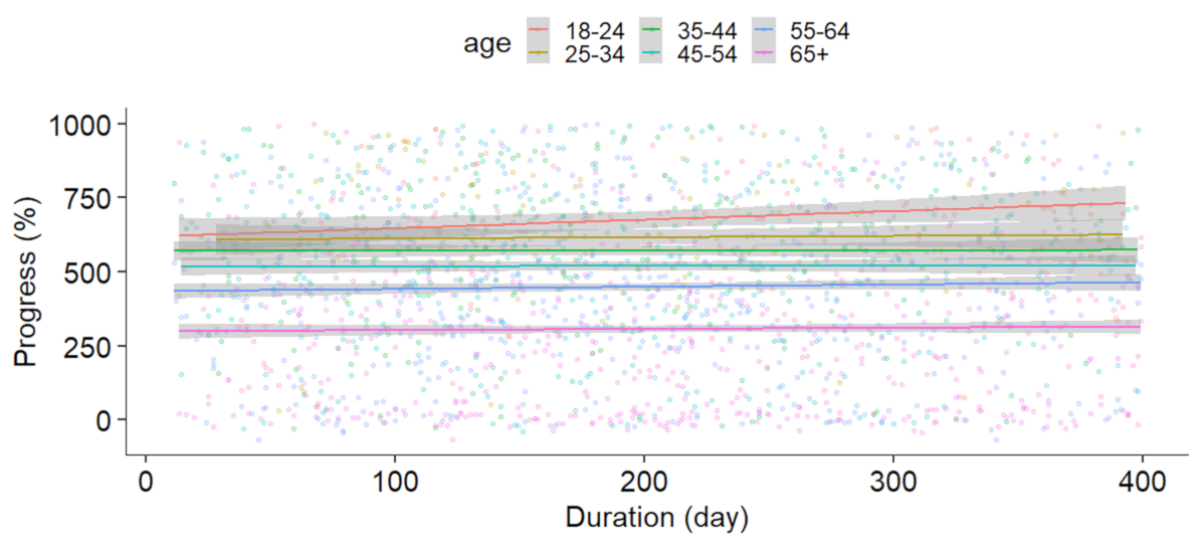
Figure 4. Linear regression between the duration of the period to perform the 100 sessions and the mean progress in the 7 cognitive mobile games for the different age groups ( β = 0.02, SE = 0.06, P